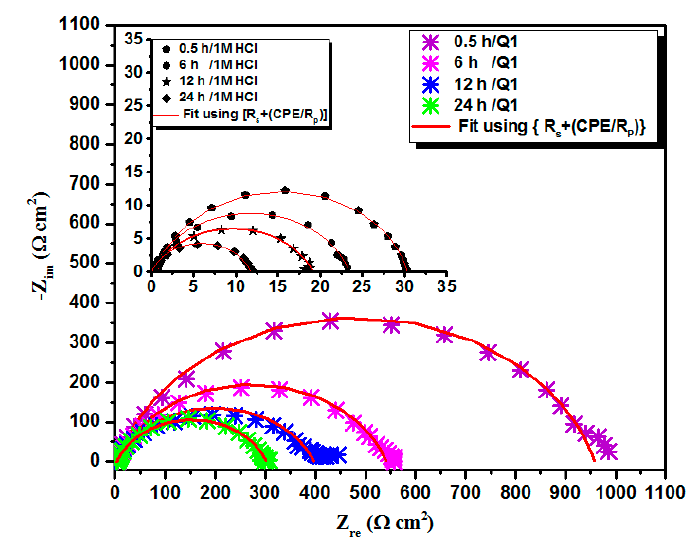
Figure 5. EIS plots of MS substrate immersed in uninhibited and inhibited solution at 303 K containing 5 × 10 − 3 M of Q1 at varied times. Table 3. E ff ect of immersion time on polarization resistance and inhibition e ffi ciency of MS in the absence and presence of